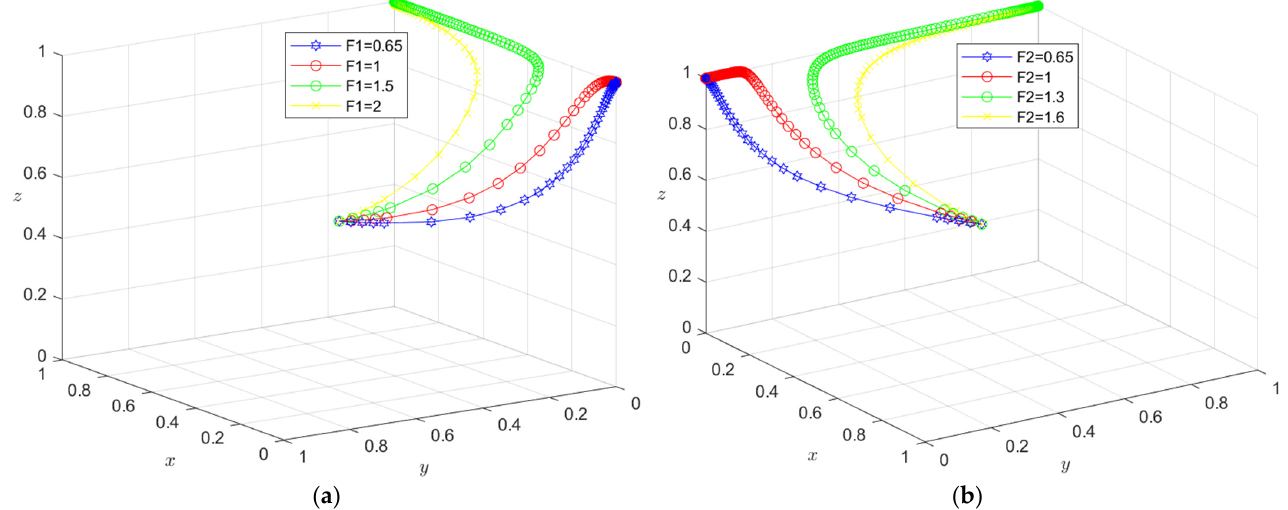
Figure 3. ( a ) Evolution path of the developer, general contractor and government under different government punishments F 1 ; ( b ) evolution path of the developer, general contractor, and government under different government punishments F 2 .